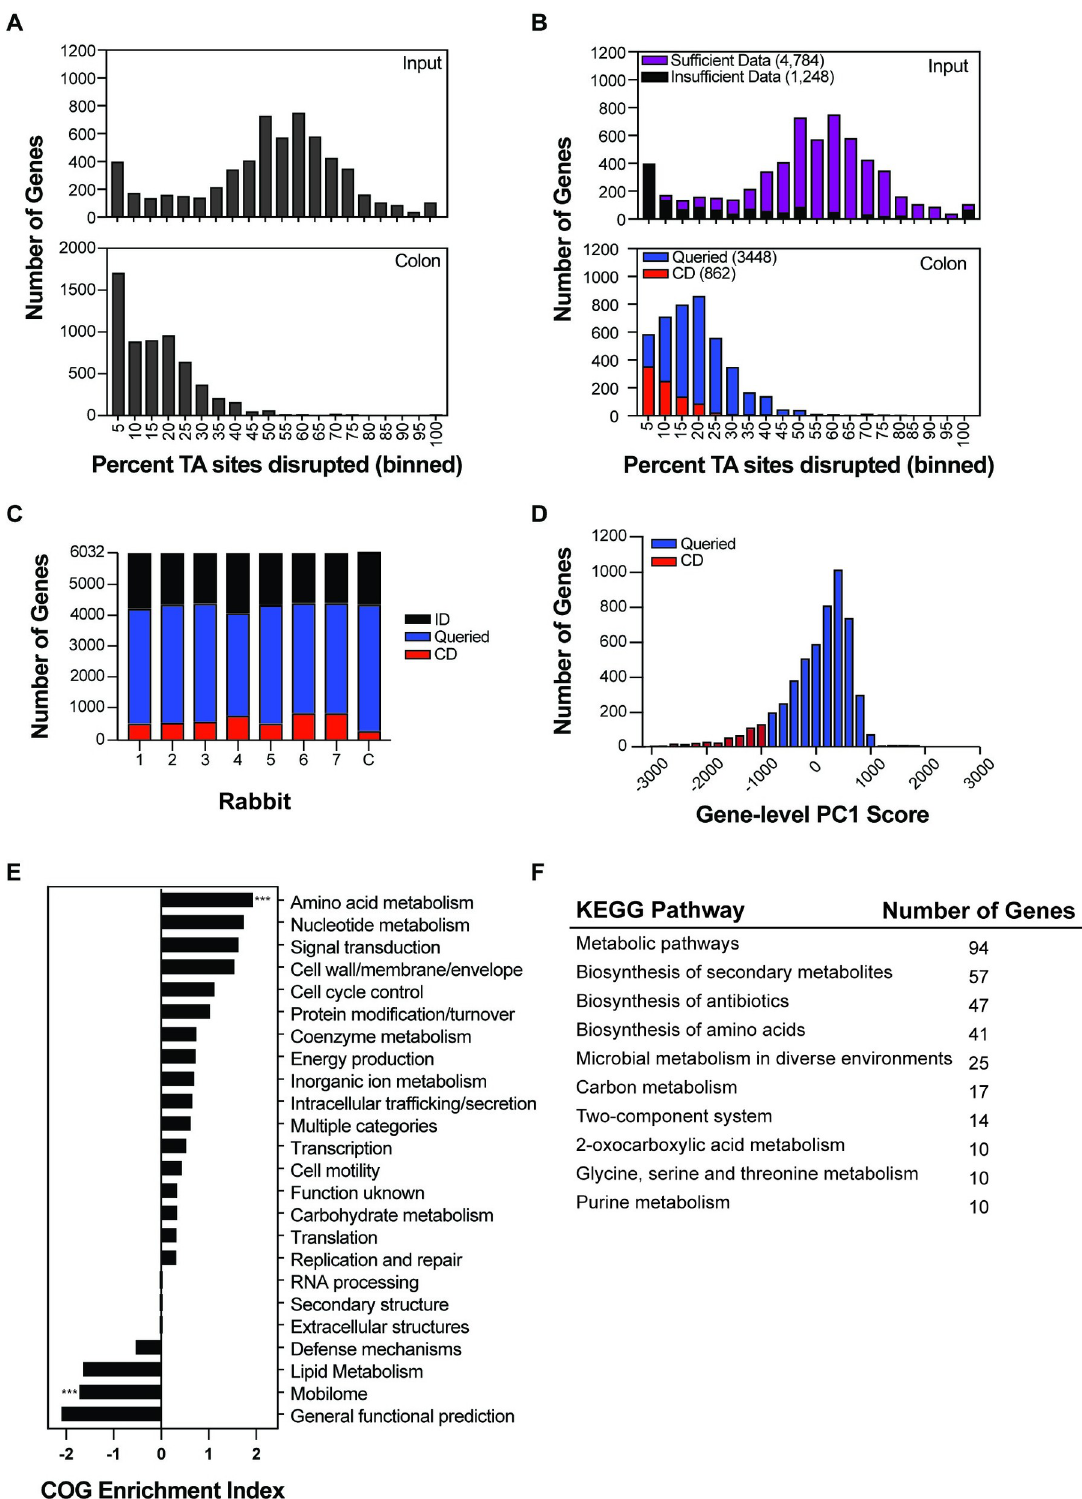
Fig 2. Identification of EHEC genes required for intestinal colonization. (A) Distribution of percentage TA site disruption for all genes in EDL933 in the library used to inoculate infant rabbits (top) and in a representative library recovered from a rabbit colon two days after infection (bottom). (B) Distribution of percentage TA site disruption for all genes in the inoculum library (top) and a